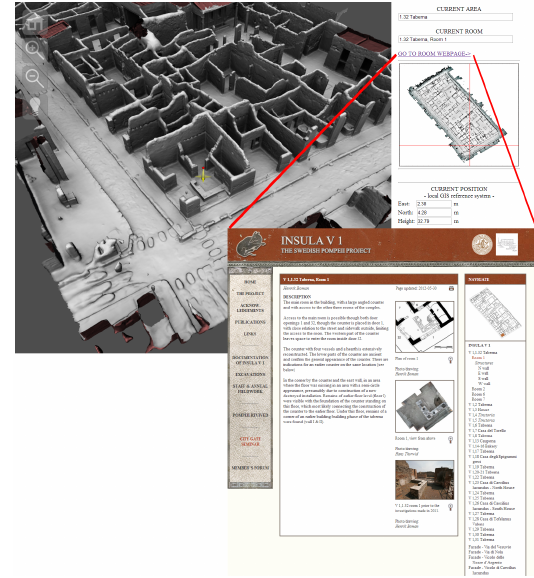
Figure 6: Linking the navigation with a data sheets